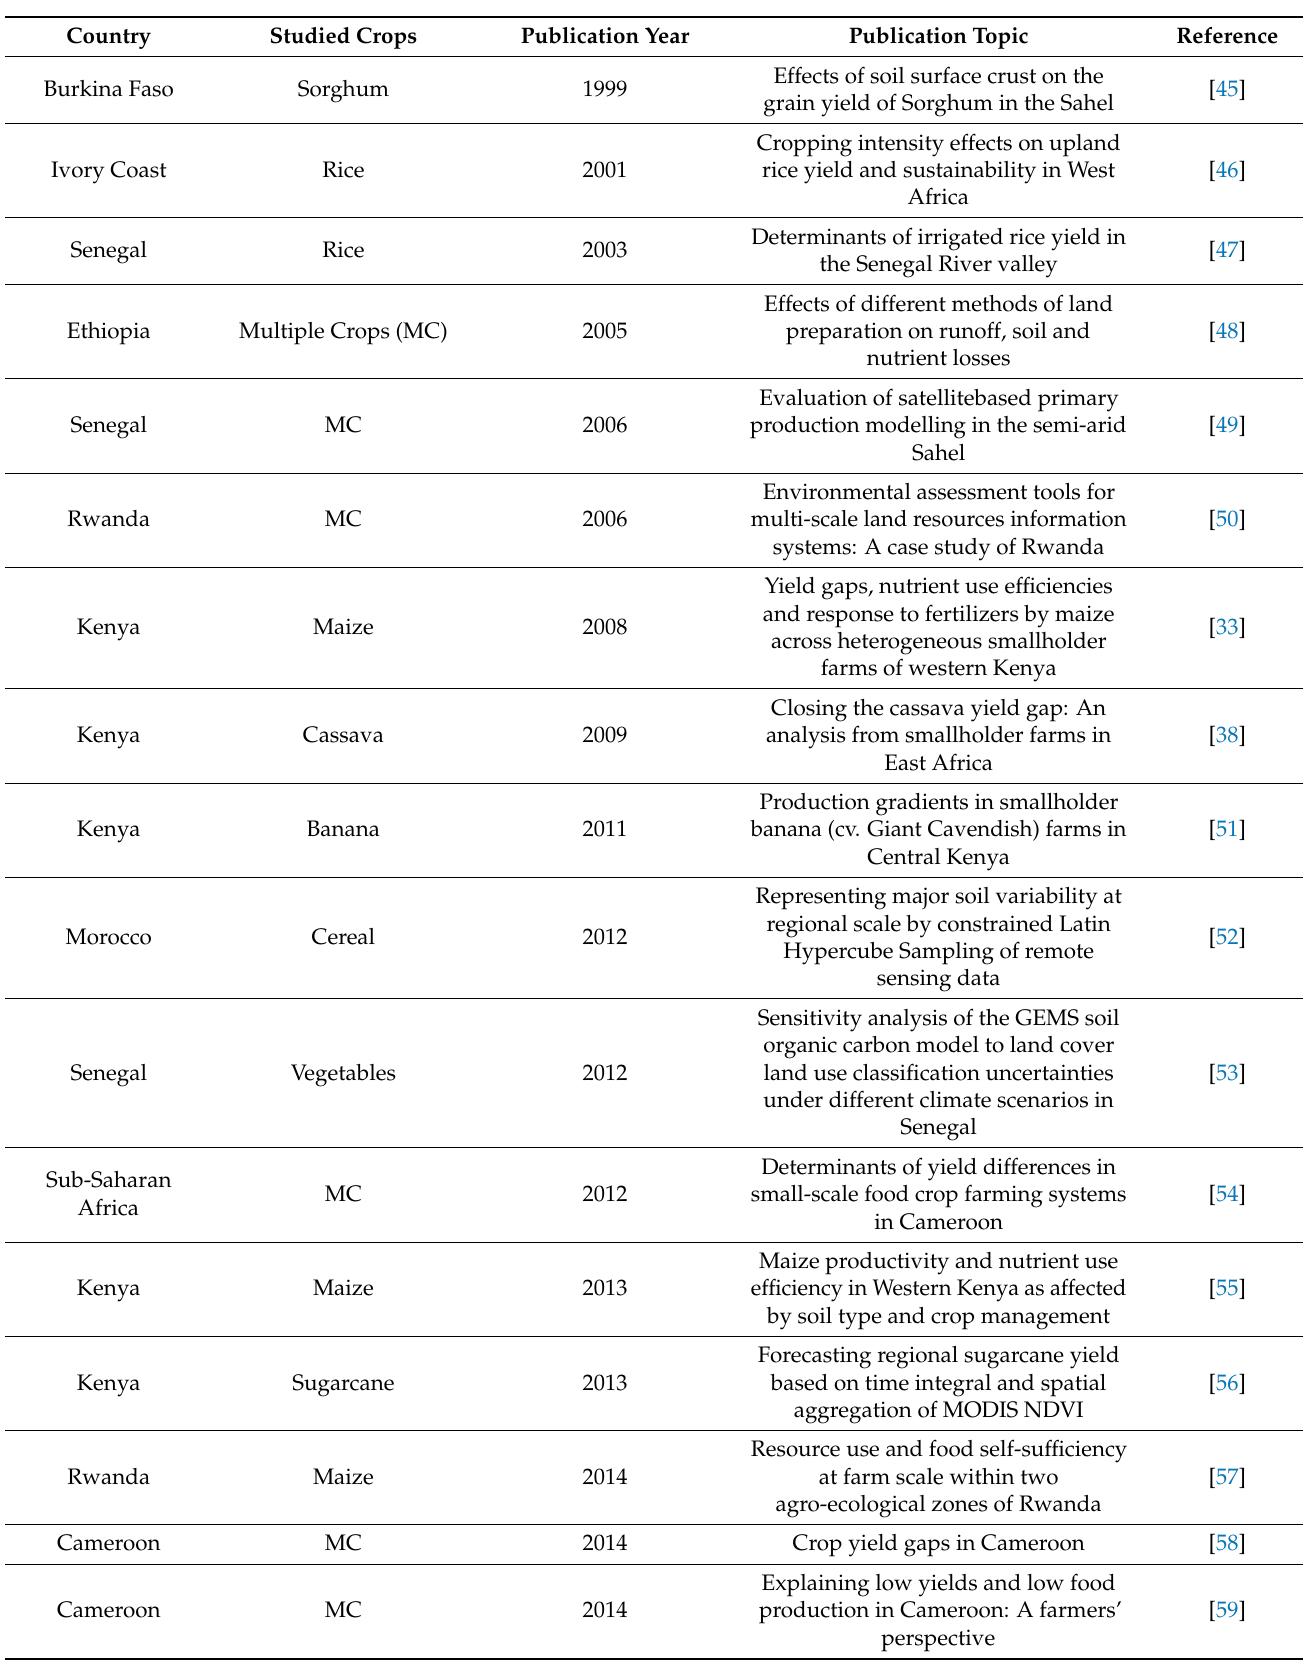
Table 2. Summary of papers used in the study for each of the 13 selected countries, sorted by publication year.